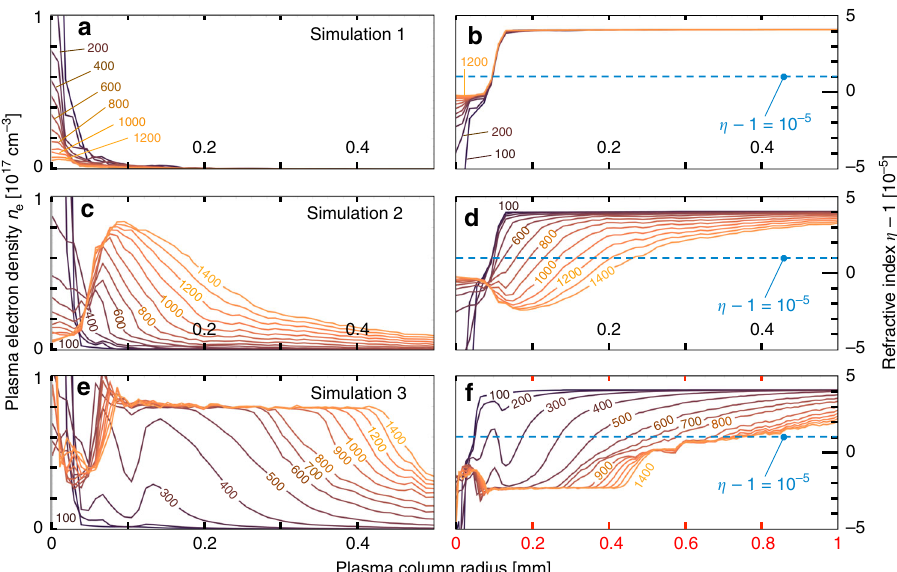
Fig. 4 LCODE simulations of evolving plasma density and refractive index. Comparison of evolution of radial plasma density distributions (left) and corresponding refractive index distributions (right) for the three models used in LCODE simulations. a – b No secondary ionization. c – d Single-step electron and ion-impact ionization from ground state. e – f Single-step plus two-step electron-impact ionization via 2P, 3S, and 3P excited states. Labels on individual curves denote Δ t in ps. Although the left-hand column plots only plasma density n e ( r ), neutral lithium atom (and, for Simulation 3, excited state) distributions are also non-uniform and evolving, and were taken into account in calculating refractive index distributions shown in the right-hand column. Horizontal blue dashed lines in the latter indicate the threshold index η = 1.00001 at which the probe re fl ects from the plasma column. Panel f has twice the horizontal axis range as other